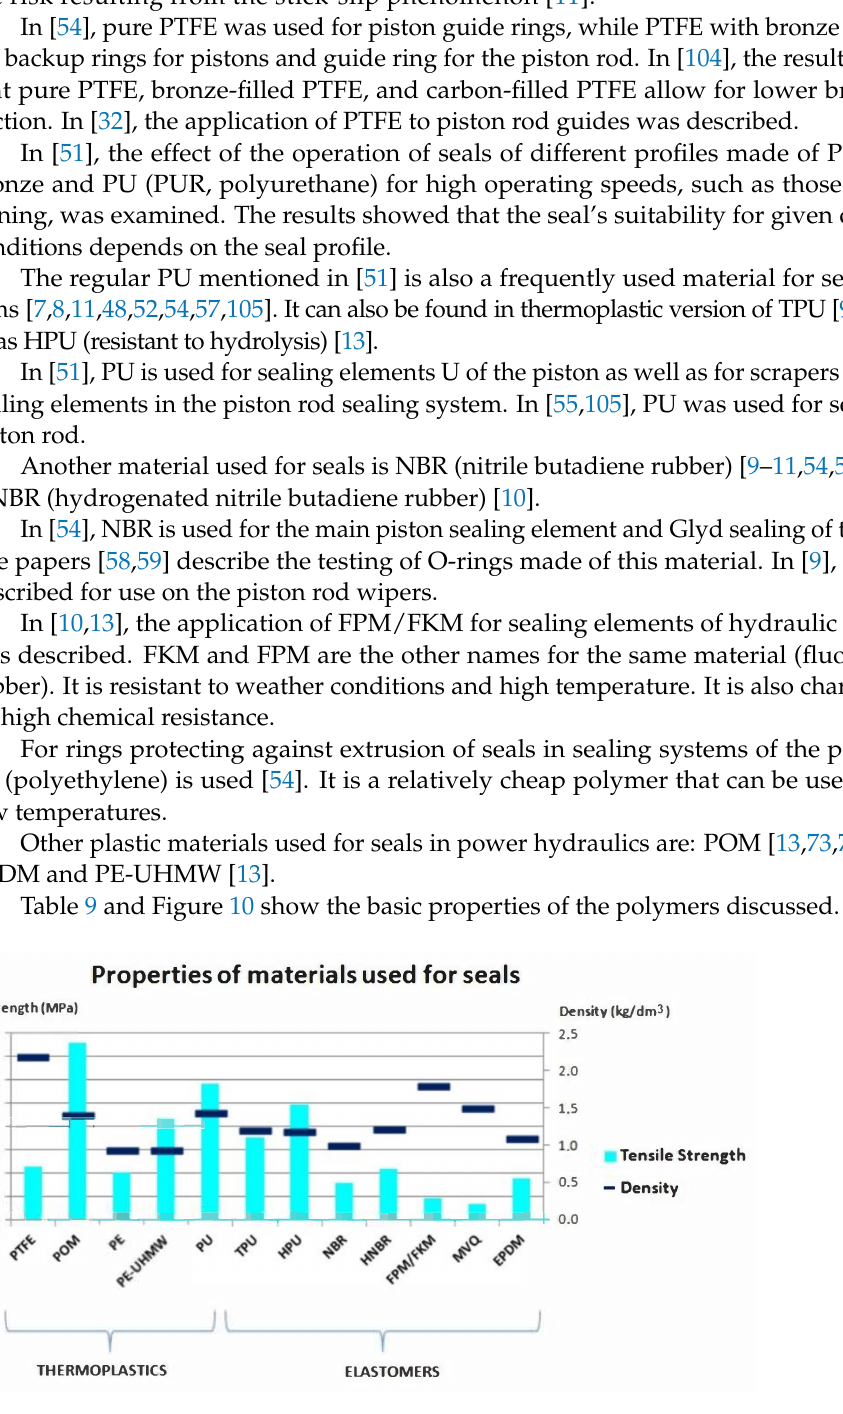
Figure 10. Chart of properties of the materials used for the